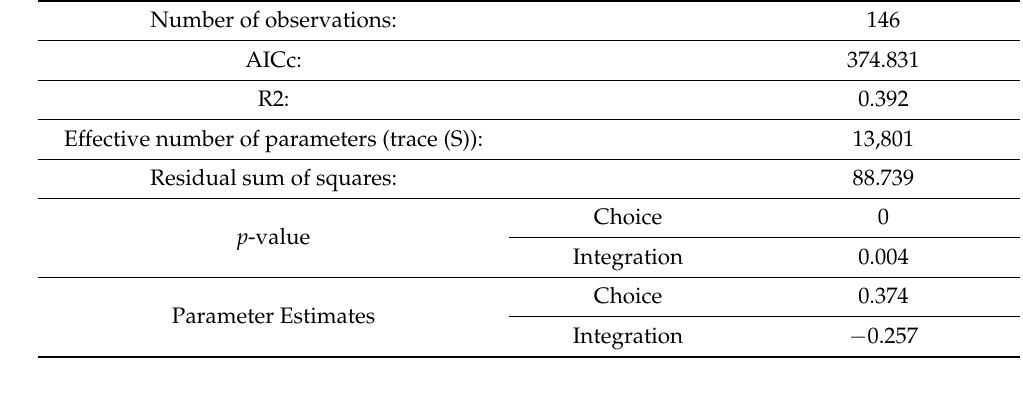
Table 2. Diagnostic information of the statistical model of the number of public participants based on GWR and CHOICE, INTEGRATION.